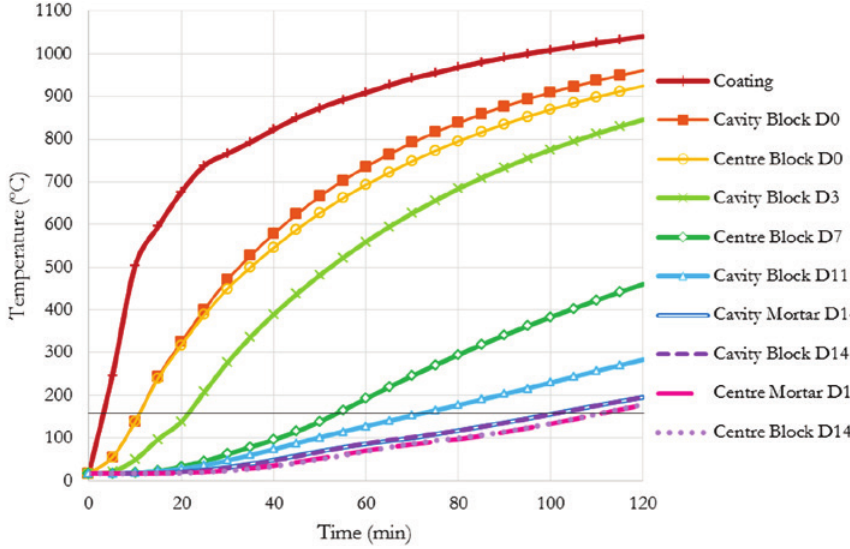
Temperature variation at various points of the coated prism on one face